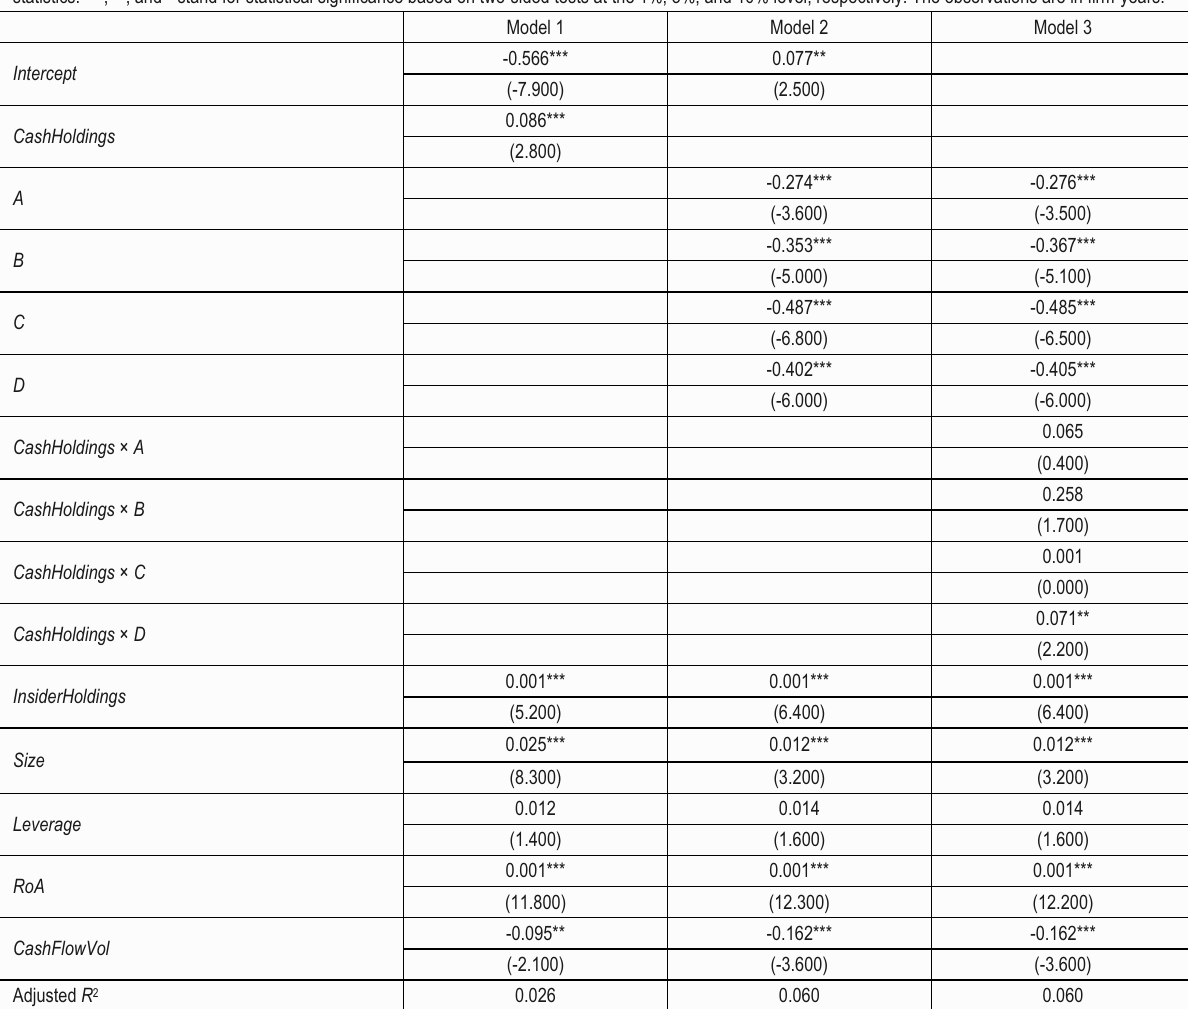
Table 8. Multivariate analysis of stock returns onto cash holdings and credit rating The dependent variable, StockReturn , is the firms’ stock return. CashHoldings is the cash holding ratio defined as cash and marketable securities divided by total assets. The bond dumours are A, including A-, A, A+, AA(-,·, +), AAA(-,·, +); B, including B(-,·, +), BB(-,·, +), BBB(-,·, +); C, including C(-,·, +), CC(-,·, +), CCC(-,·, +); D, including D group ratings; and NA for unidentified ratings. These credit ratings are the most conservative ones among 3 major credit rating agencies in Korea: KBP, NICE, and KIS. InsiderHoldings , as a proxy for corporate governance, is defined as the proportion of block holders with stakes exceeding 10%. Assets are defined as the total assets net of cash and cash equivalents. Size is measured as the natural log of assets. Leverage is measured as the ratio of total debt to asset. RoA is the firm’s net profits divided by its total assets. CashFlow is the he cash flow ratio measured as the arnings after interest, dividend, and taxes, but before depreciation, divided by assets. CashFlowVol is the standard deviation of the firm’s cash flows, a proxy for business conditions, is computed using the firm’s standard deviation of the cash flow ratio for the past 5 years. The parenthesized numerical values below coefficient estimates are the t- statistics. ***, **, and * stand for statistical significance based on two-sided tests at the 1%, 5%, and 10% level, respectively. The observations are in